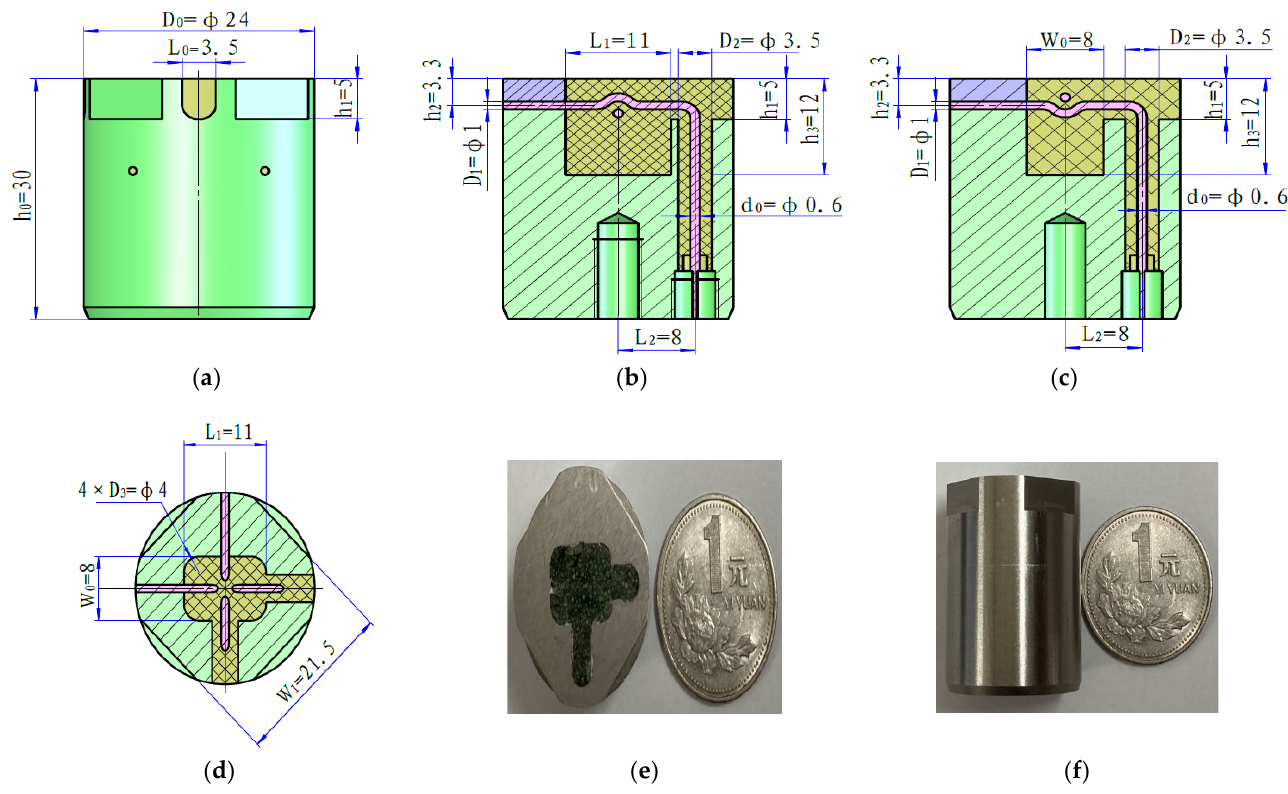
Figure 2. Three-dimensional model and physical dual-polarization slot antenna (mm): ( a ) three-dimensional model; ( b ) frontal anatomical view; ( c ) lateral anatomical view; ( d ) top view; ( e ) physical top view; and ( f ) physical side view of the antenna.